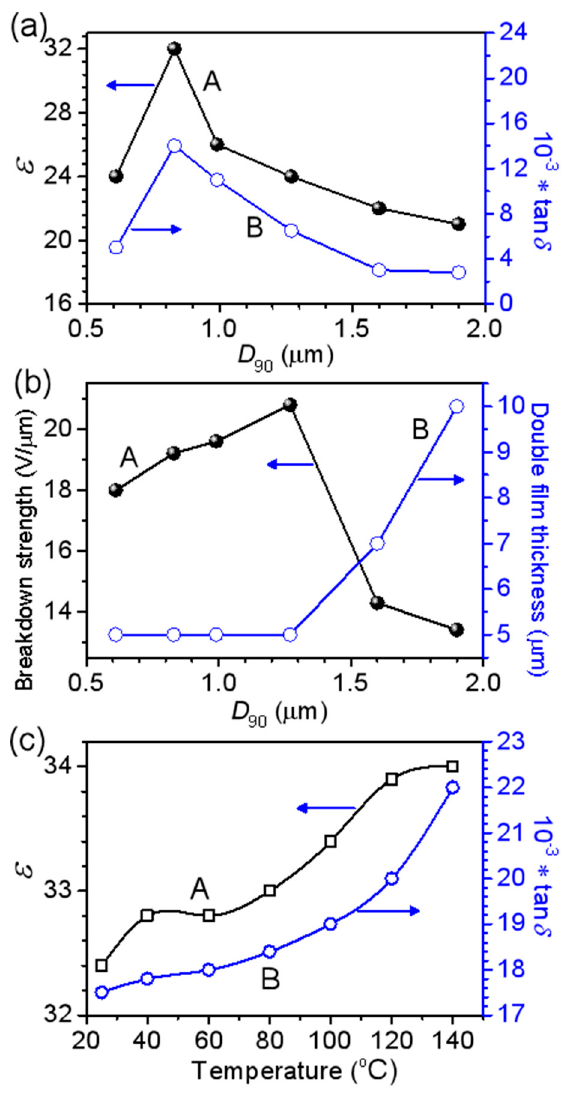
Figure 8. ( a ) Dielectric constant and loss of the BPA films obtained via Route 2 as a function of BT particle size ( M BT / M polymer = 4); ( b ) Breakdown strength and film double layer thickness of the BPA films as a function of BT particle size ( M BT / M polymer = 4); ( c ) Dielectric constant and loss of the BPA films obtained via Route 2 as a function of testing temperature ( M BT / M polymer = 4 ， D 90 = 0.83 μ m).